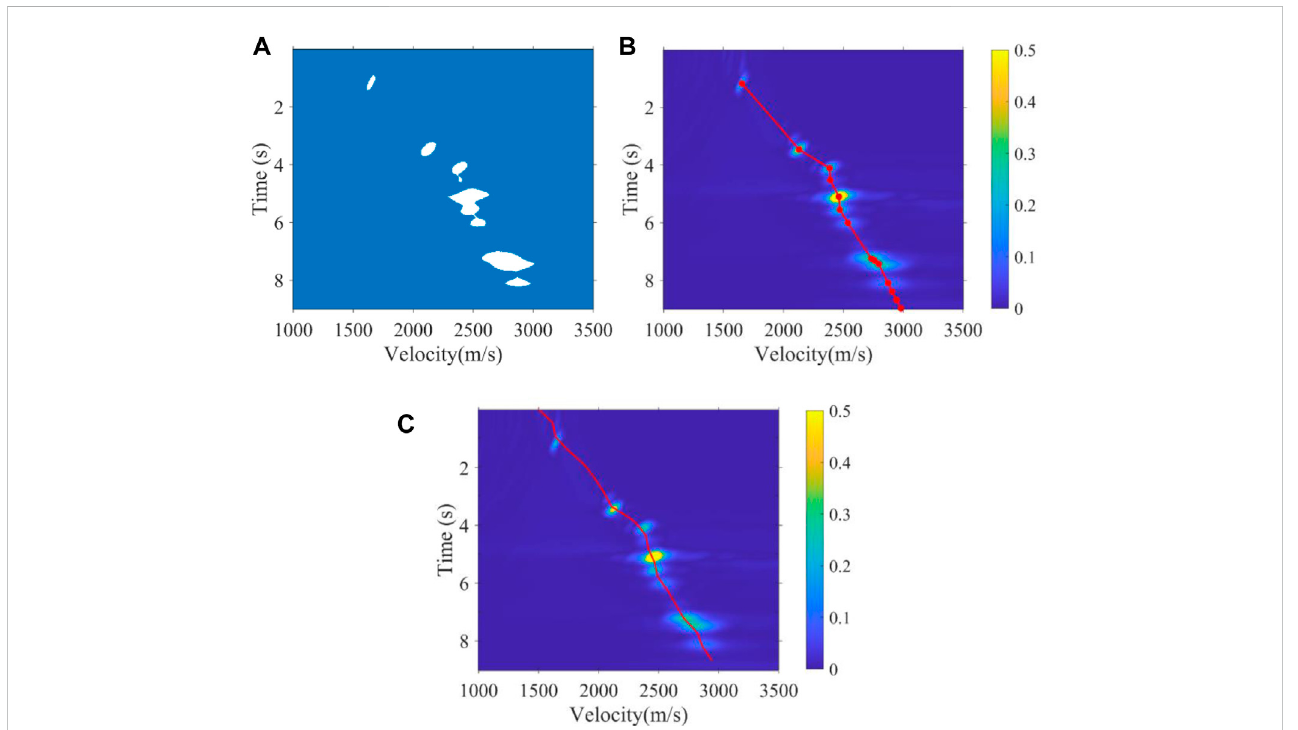
FIGURE 4 40thvelocityspectrumoftheMarmuosimodel. (A) Segmentationresult, (B) intelligentpicking resultbyusingthemethodproposed,and (C) realvelocity curve.